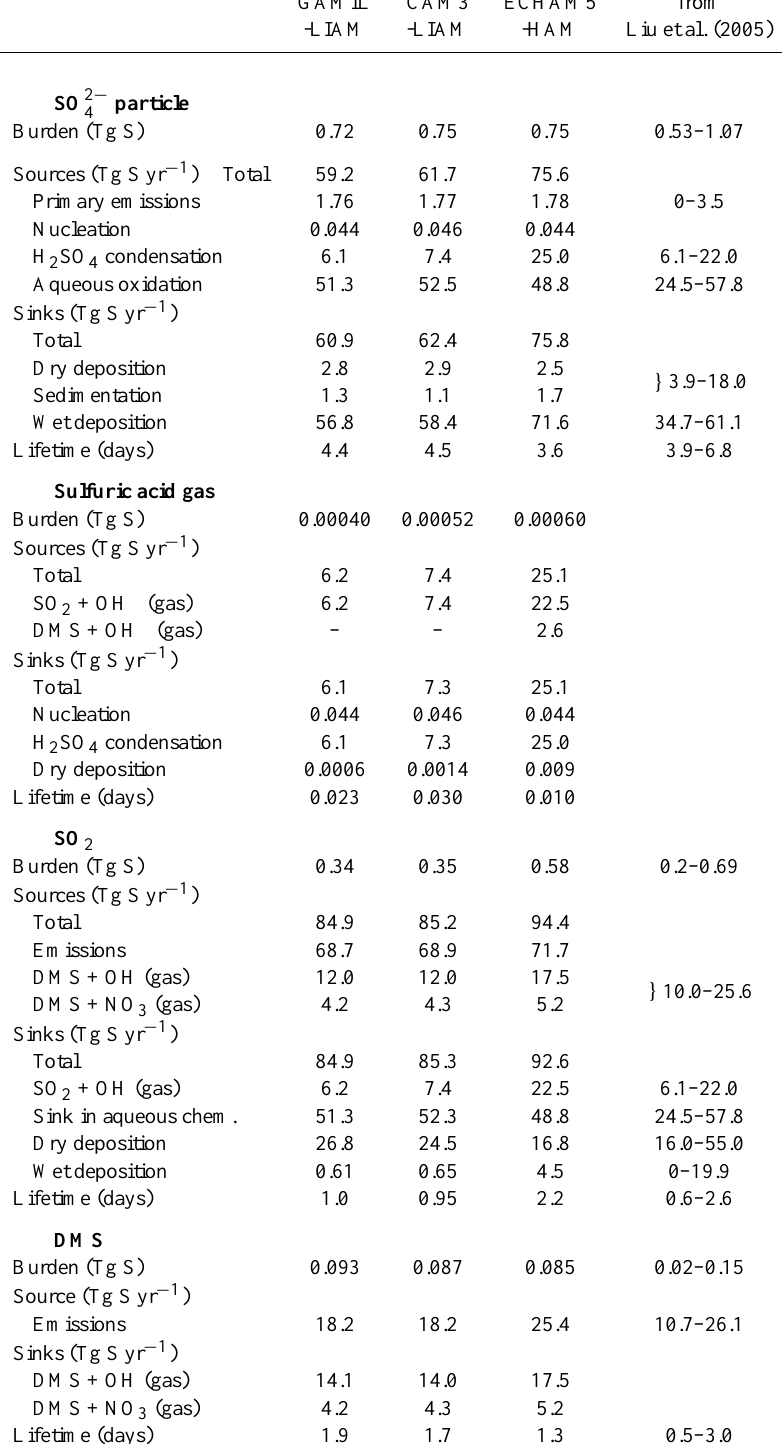
Table 5. Annual mean global sulfur budget obtained in this study and from the